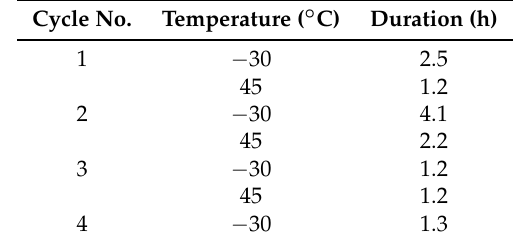
Table 6. Durations of hot and cold dwells during Thermal vacuum cycles. Cycle No.